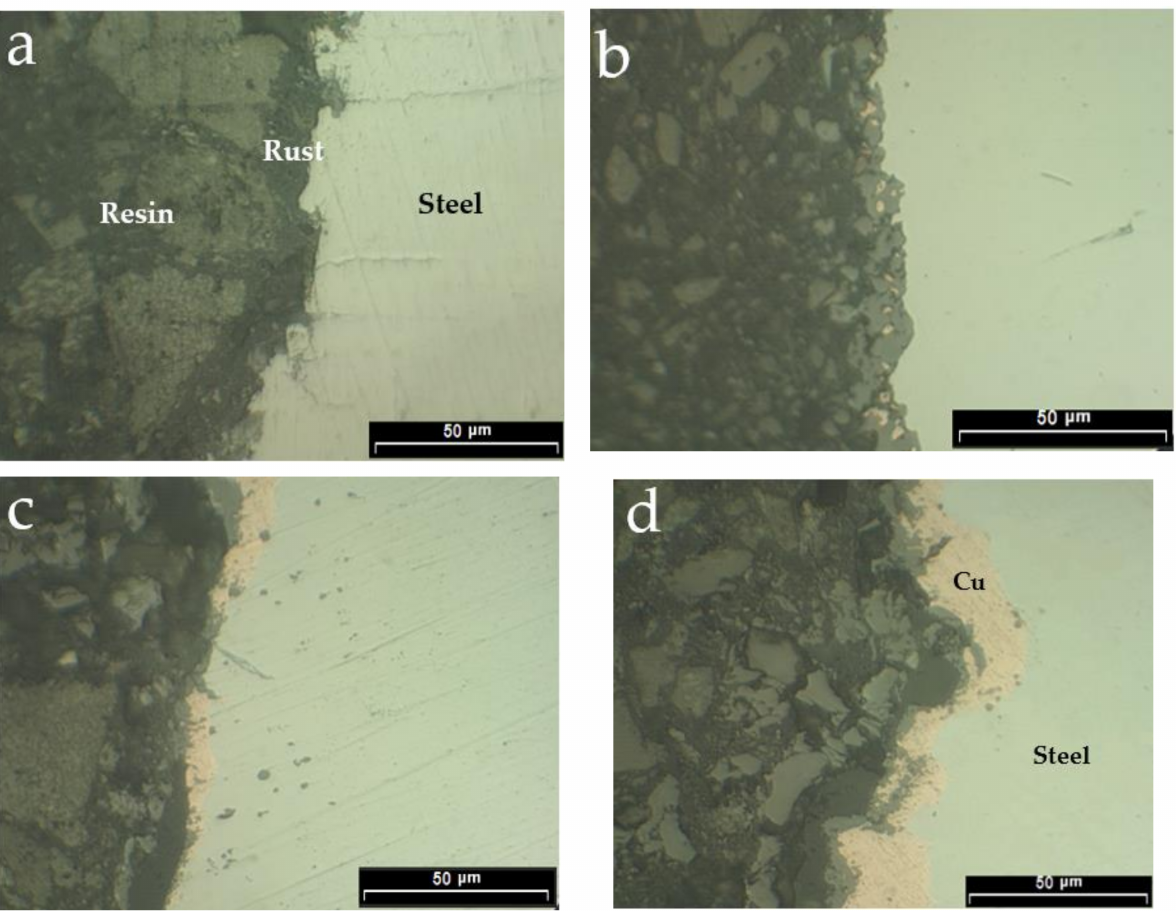
Figure 4. Optical microscope picture of inclined cross section of steel 1 ( a ), 2 ( b ), 3 ( c ), and 4 ( d ) after